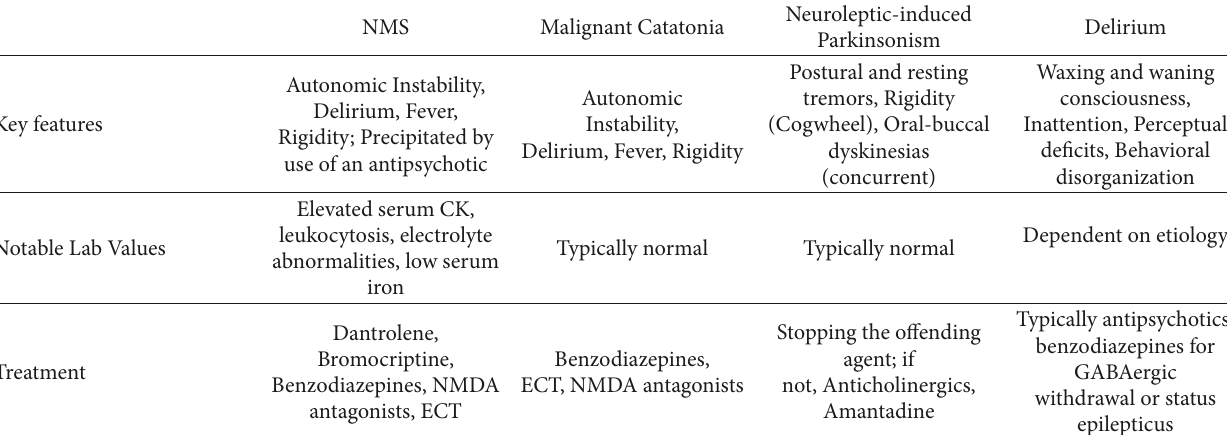
Table 1: Differential